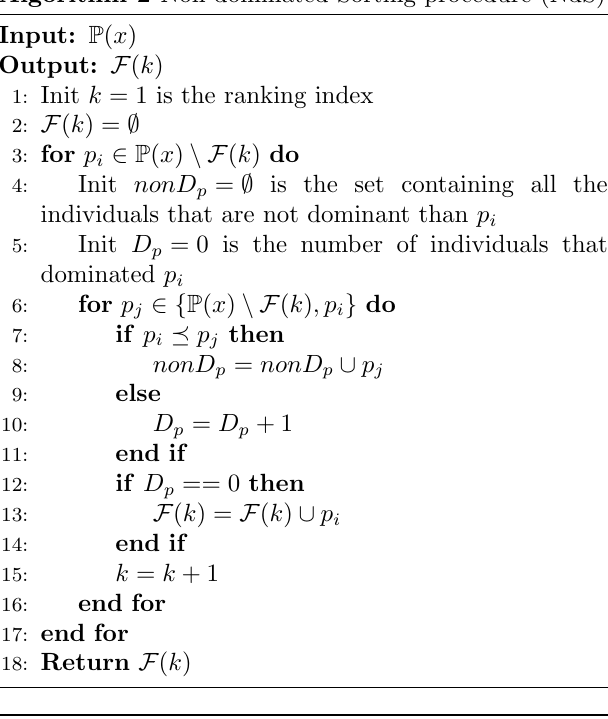
Algorithm 3 Crowding distance calculator